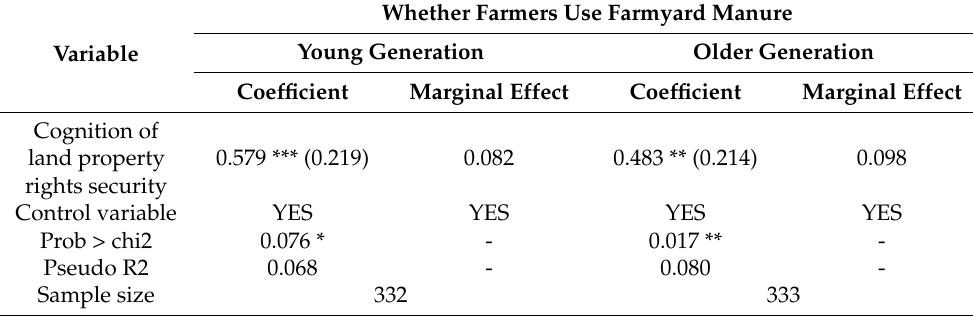
Table 4. Comparative analysis of farmers in different